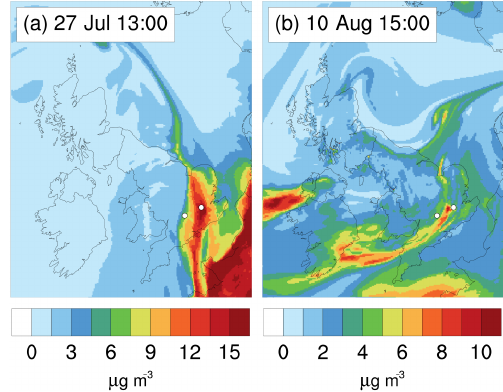
Figure 10. Modelled (addDiesel experiment) hourly concentrations of SOA at the time of the maximum measured hourly SOA value at the London North Kensington site during the first and second SOA episodes of the summer IOP. The white circles mark the measure- ment site locations – left: Harwell; right: London North